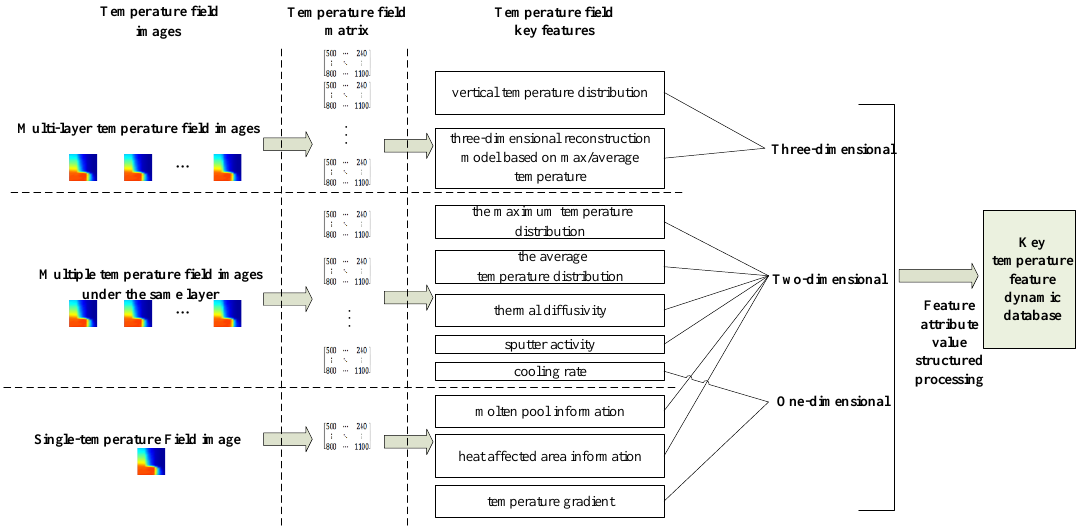
Figure 1. Definition of key features of the temperature field.